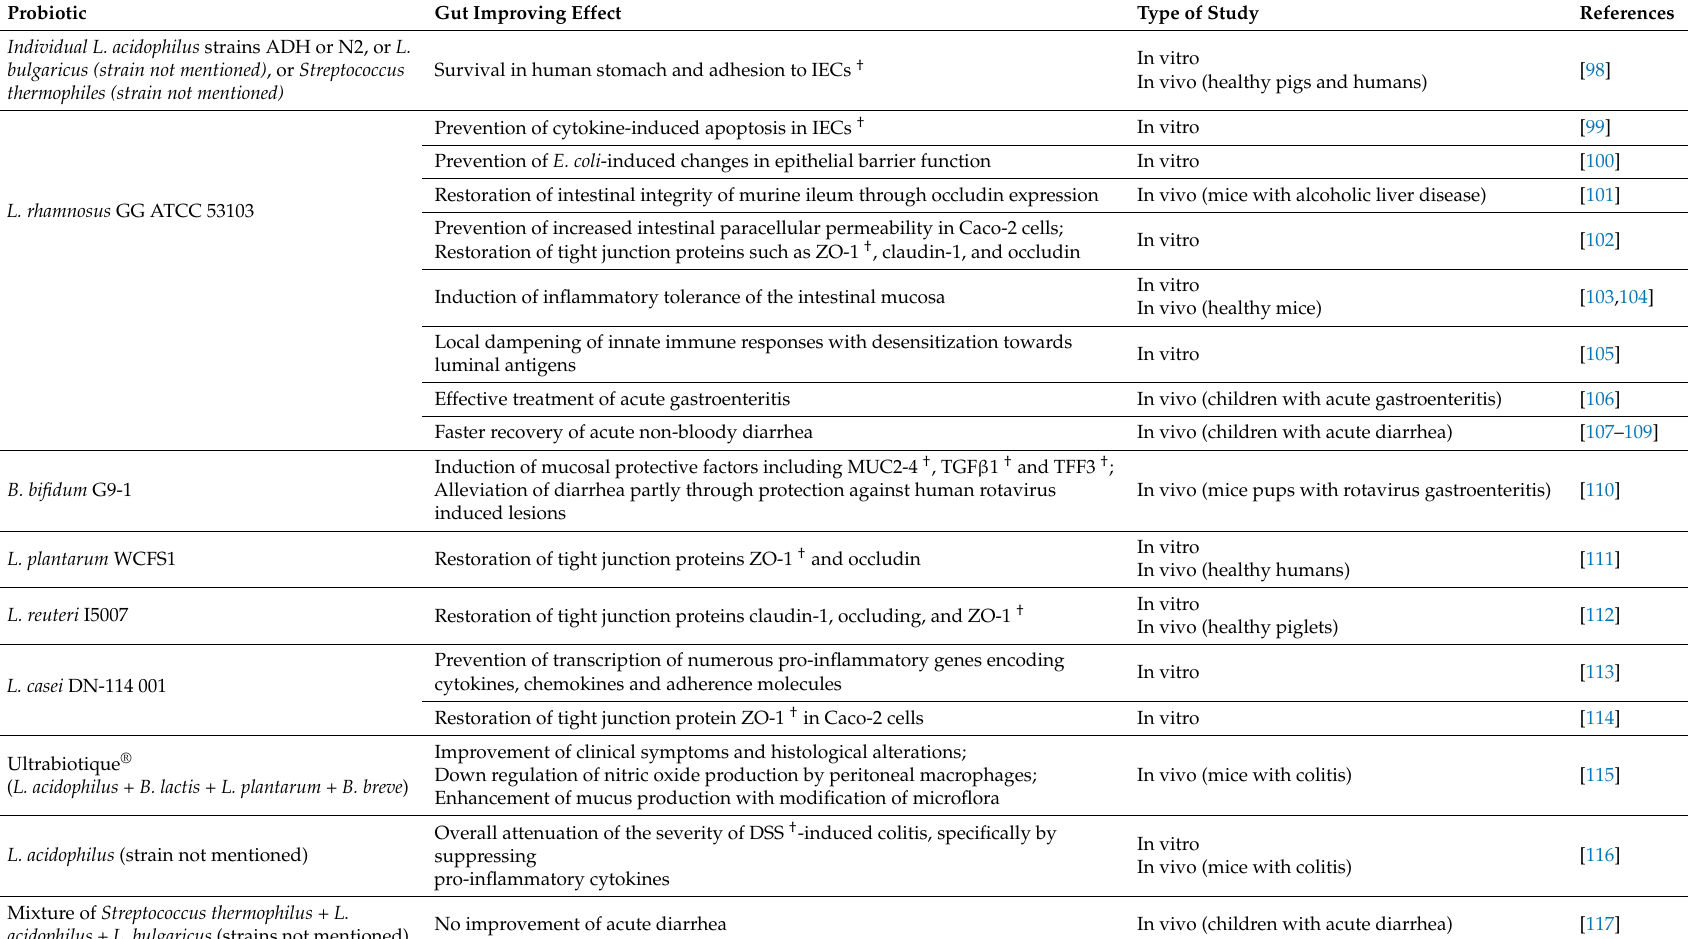
Table 1. Overview of experimental studies on probiotic strategies for improving general gastrointestinal